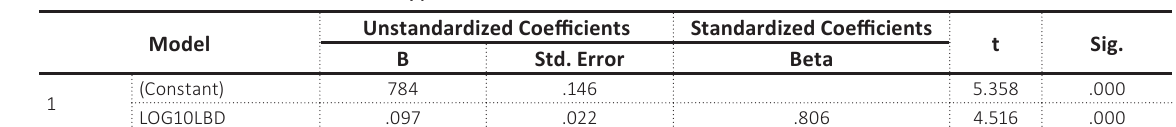
Table 4c. Coefficients result for hypothesis one